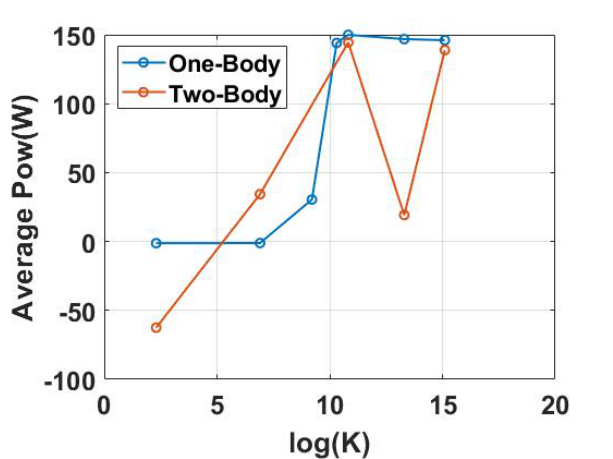
Fig. 4: The power extracted from the first and the second mass with control limitation 7000 N and mooring stiffness 5 × 10 4 N/m.